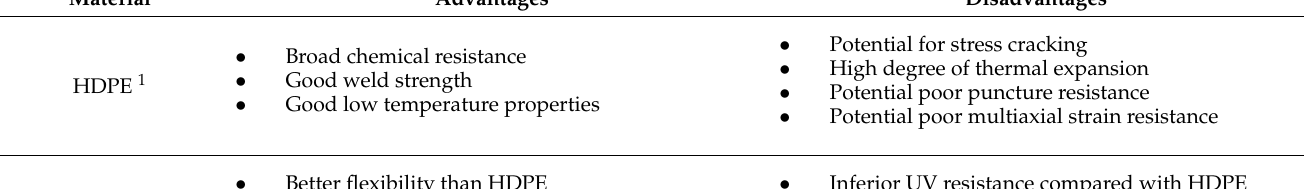
Table 2. Advantages and disadvantages of typically used geomembranes according to Scheirs [65] and Fourie et al. [30], complemented with data on the properties of bituminous geomembrane (BGM) [63,64]. Material